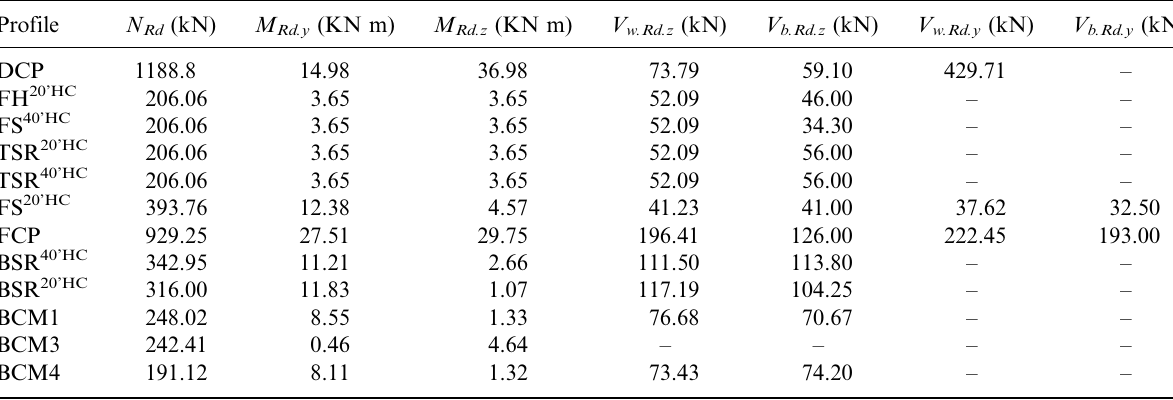
Table 11. Design strengths for profiles (gross sections) Profile